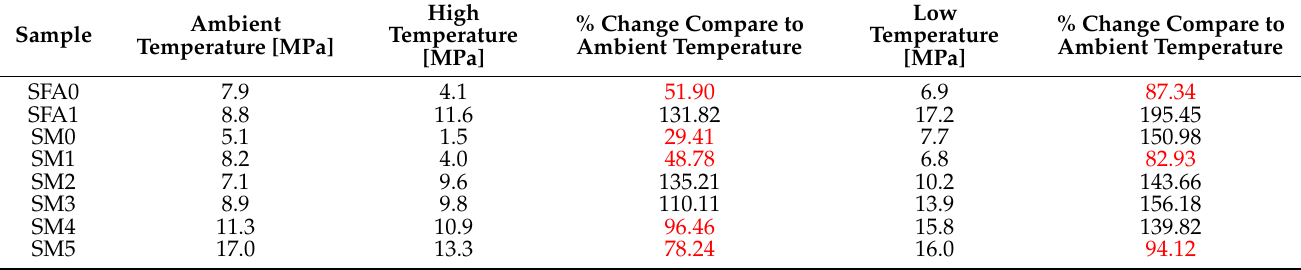
Table 2. Compositions of prepared